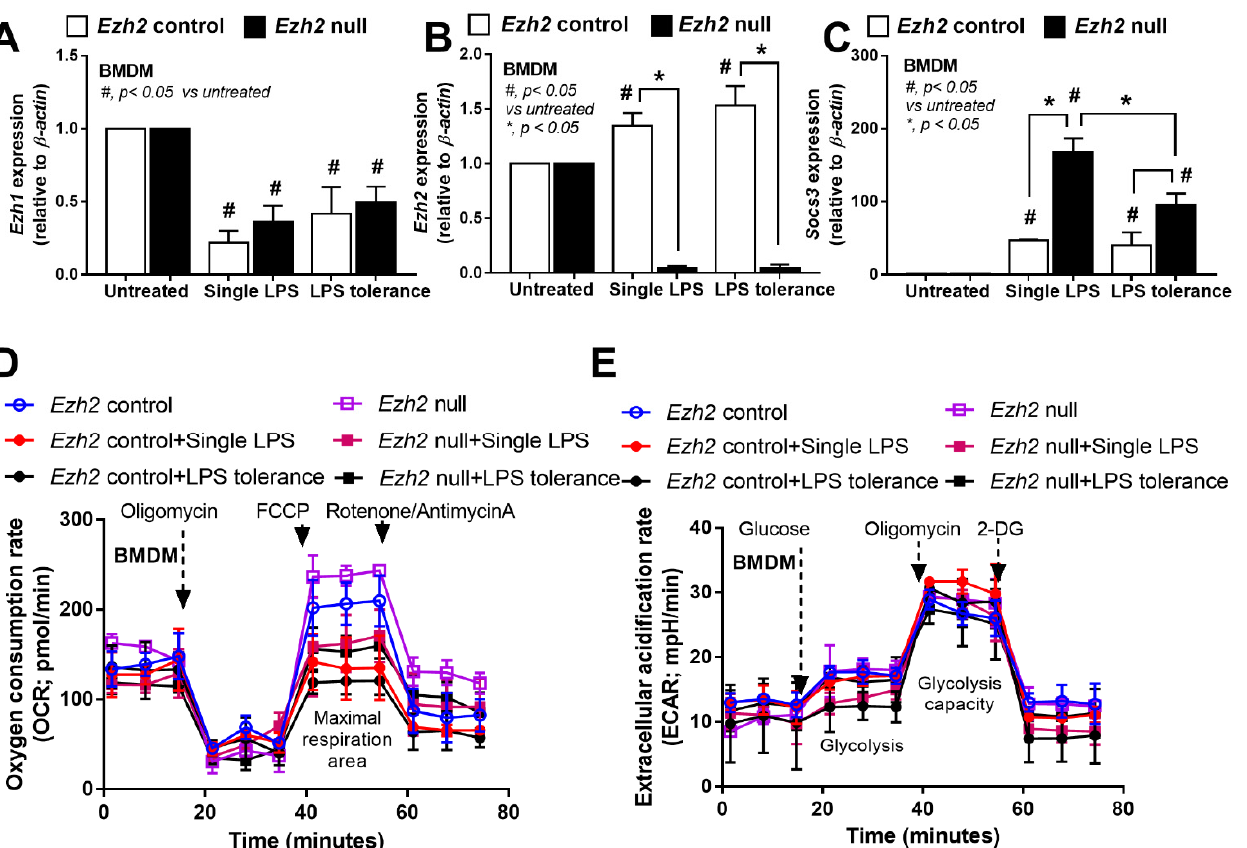
Figure 4. Characteristics of bone-marrow-derived macrophages (BMDM) from Ezh2 control ( Ezh fl/fl ; LysM-Cre − / − ) or Ezh2 null ( Ezh fl/fl ; LysM-Cre cre/ − ) mice 24 h after stimulation by lipopolysaccharide (LPS) tolerance (twice LPS stimulation; LPS/LPS) or a single LPS stimulation (N/LPS; started with